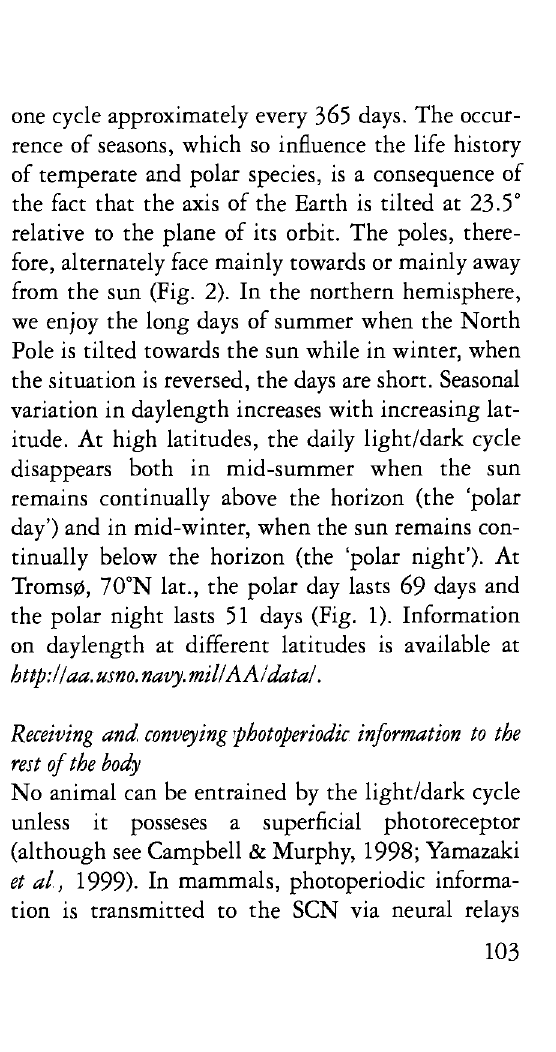
Fig. 2. The figure shows the revolution of the Earth around its axis and the consequential occurence of night and day. Seasons are a result of the tilting of the Earth's axis which causes different parts of the Earth, in turn, to face predominantly towards or away from the sun. The seasons are indicated for the northern hemisphere. The arrows show how sunlight is absent north of the Arctic circle in winter, while there is continuous daylight there in